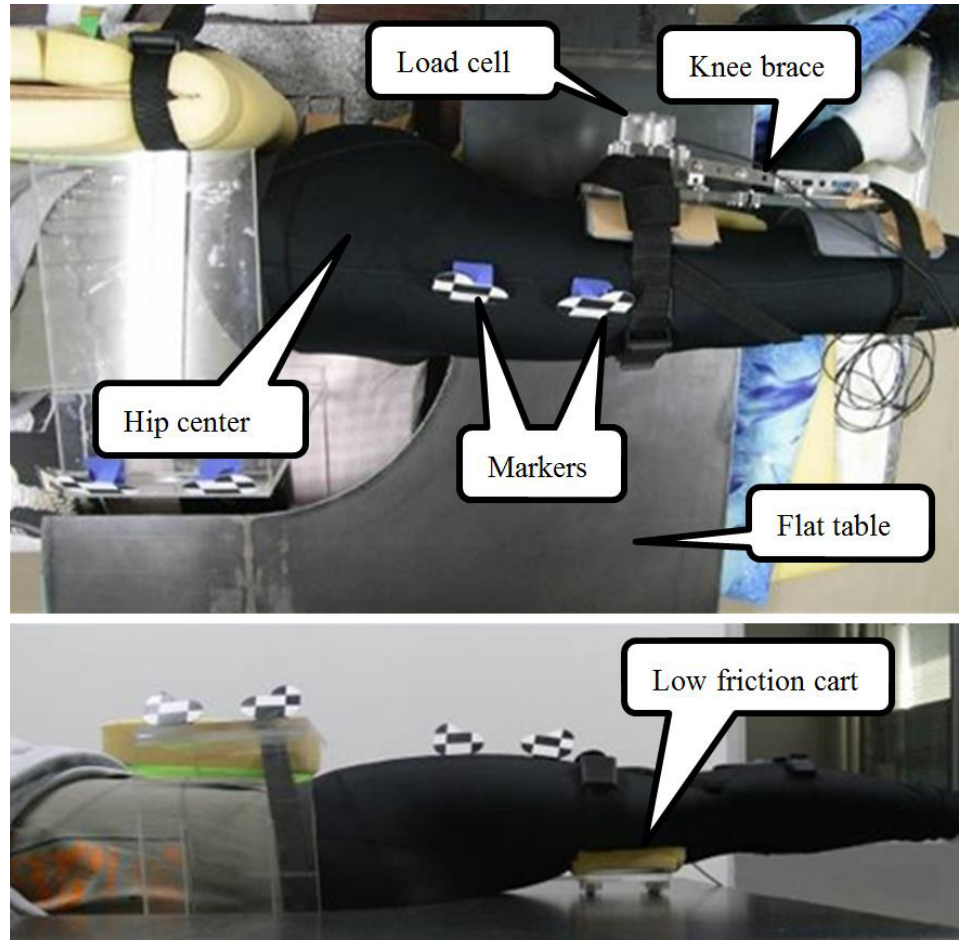
Figure 1 These two pictures show experimental set-up and a subject viewed from above (top) and from horizon (bottom). The subject lay in a left lateral decubitus position with the knee was fixed at 0 degrees in flexion in these pictures. Every apparatus required to measure (e.g., the knee brace, the load cell, reflection markers and the low friction cart) were